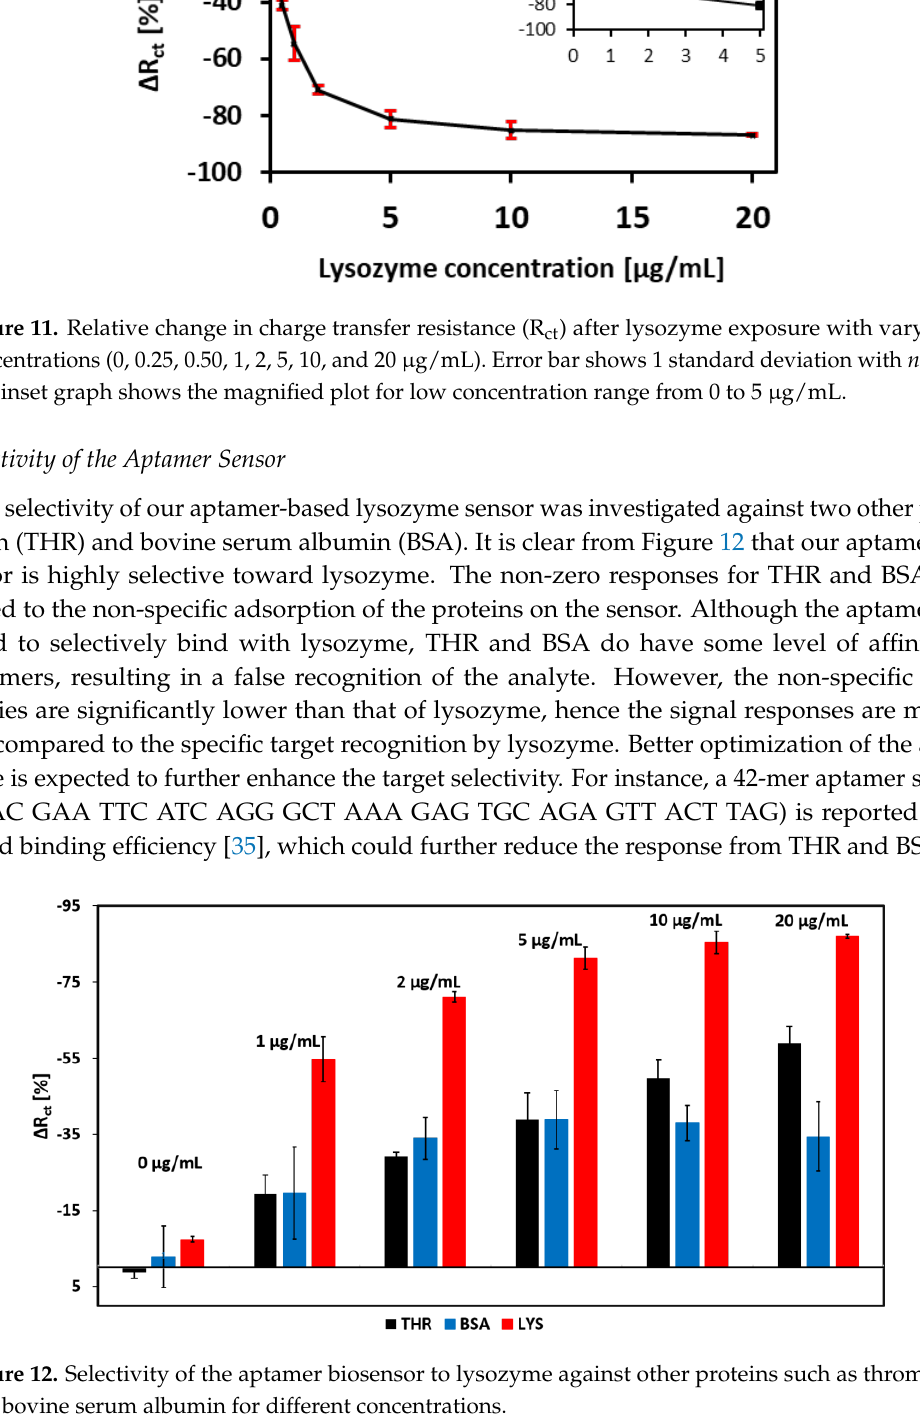
11 of 17 Figure 10. Post-lysozyme exposure Nyquist curves for different concentrations of lysozyme: ( a ) 0 µg/mL; ( b ) 0.25 µg/mL; ( c ) 0.50 µg/mL; ( d ) 1 µg/mL; ( e ) 2 µg/mL; ( f ) 5 µg/mL; ( g ) 10 µg/mL; and ( h ) 20 µg/mL. The dotted lines are the experimental data and the solid lines in red are theoretical curves based on the modified Randles circuit.